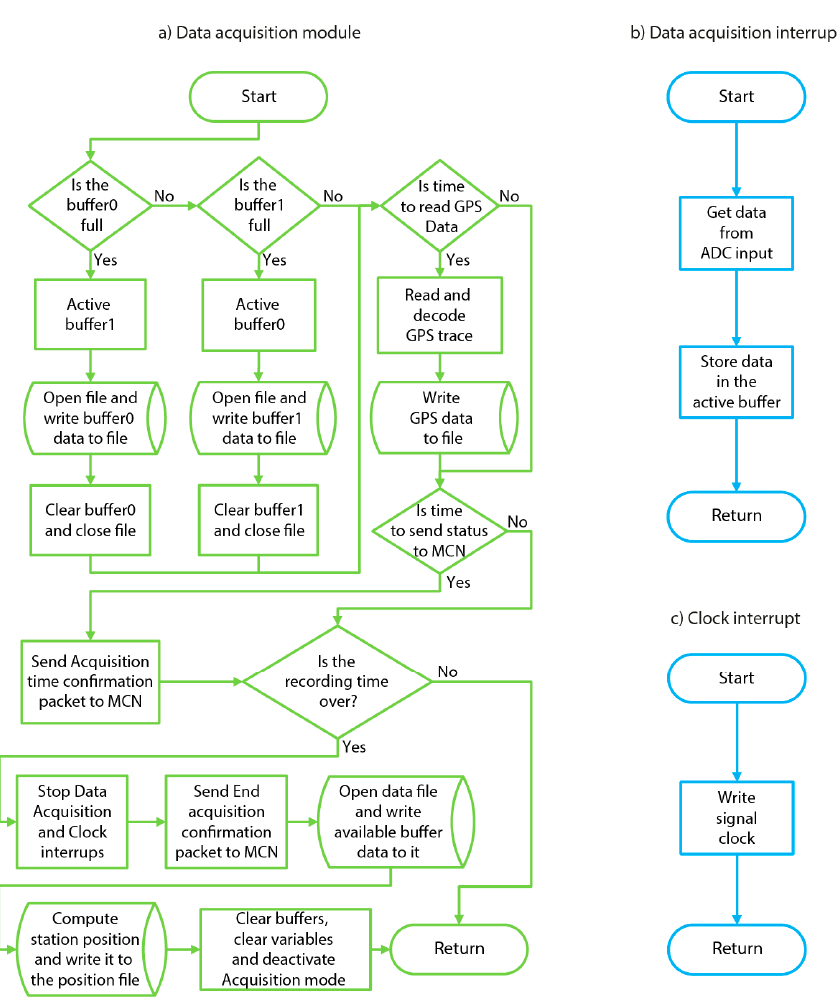
Figure 11. Detailed flowchart of the ACN software (“Data acquisition module”) and the associated interrupts.